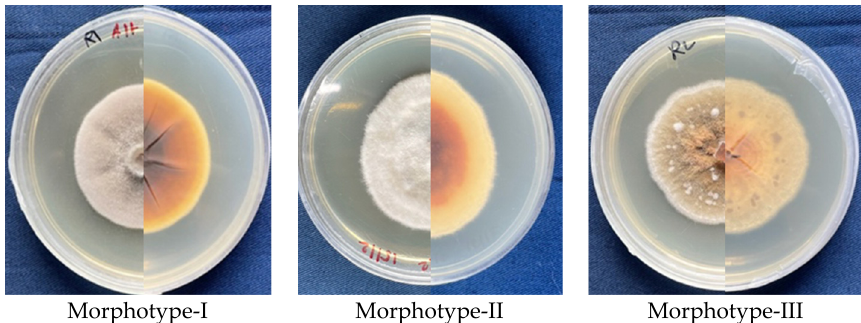
Figure 2. Representative morphotypes of Alternaria isolates characterized in the current study. Front and back of seven-day-old colonies grown on PDA at 25 °C.